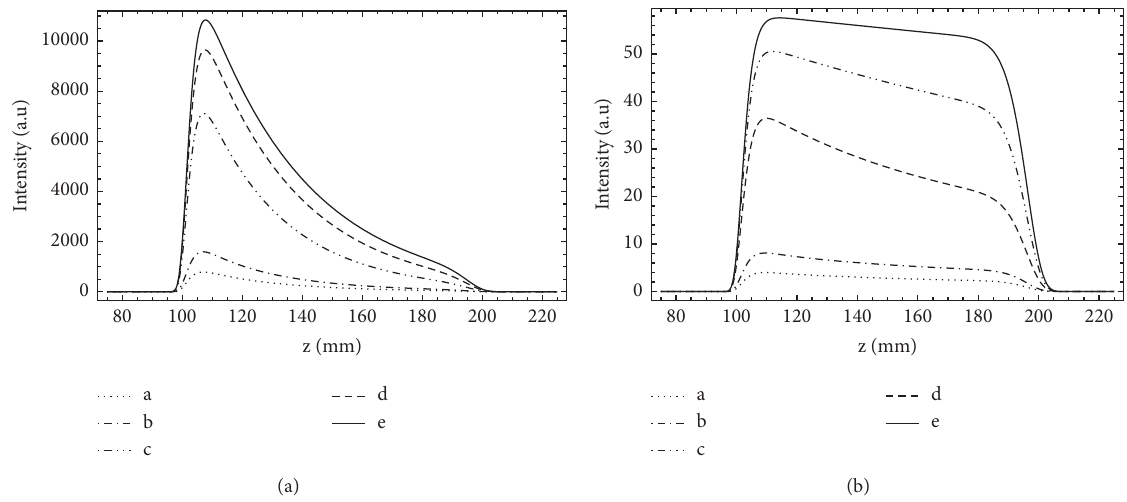
Figure 7: On-axis intensity distributions I (0, z) produced by an annular-aperture logarithmic axicon illuminated by partially coherent Lorentz–Gauss beam with different incident beam widths of (a) w with coherence widths σ of (A) 0 . 5mm, (B) 1mm, (C) 4mm, (D) 8mm, and (E) ∞ .